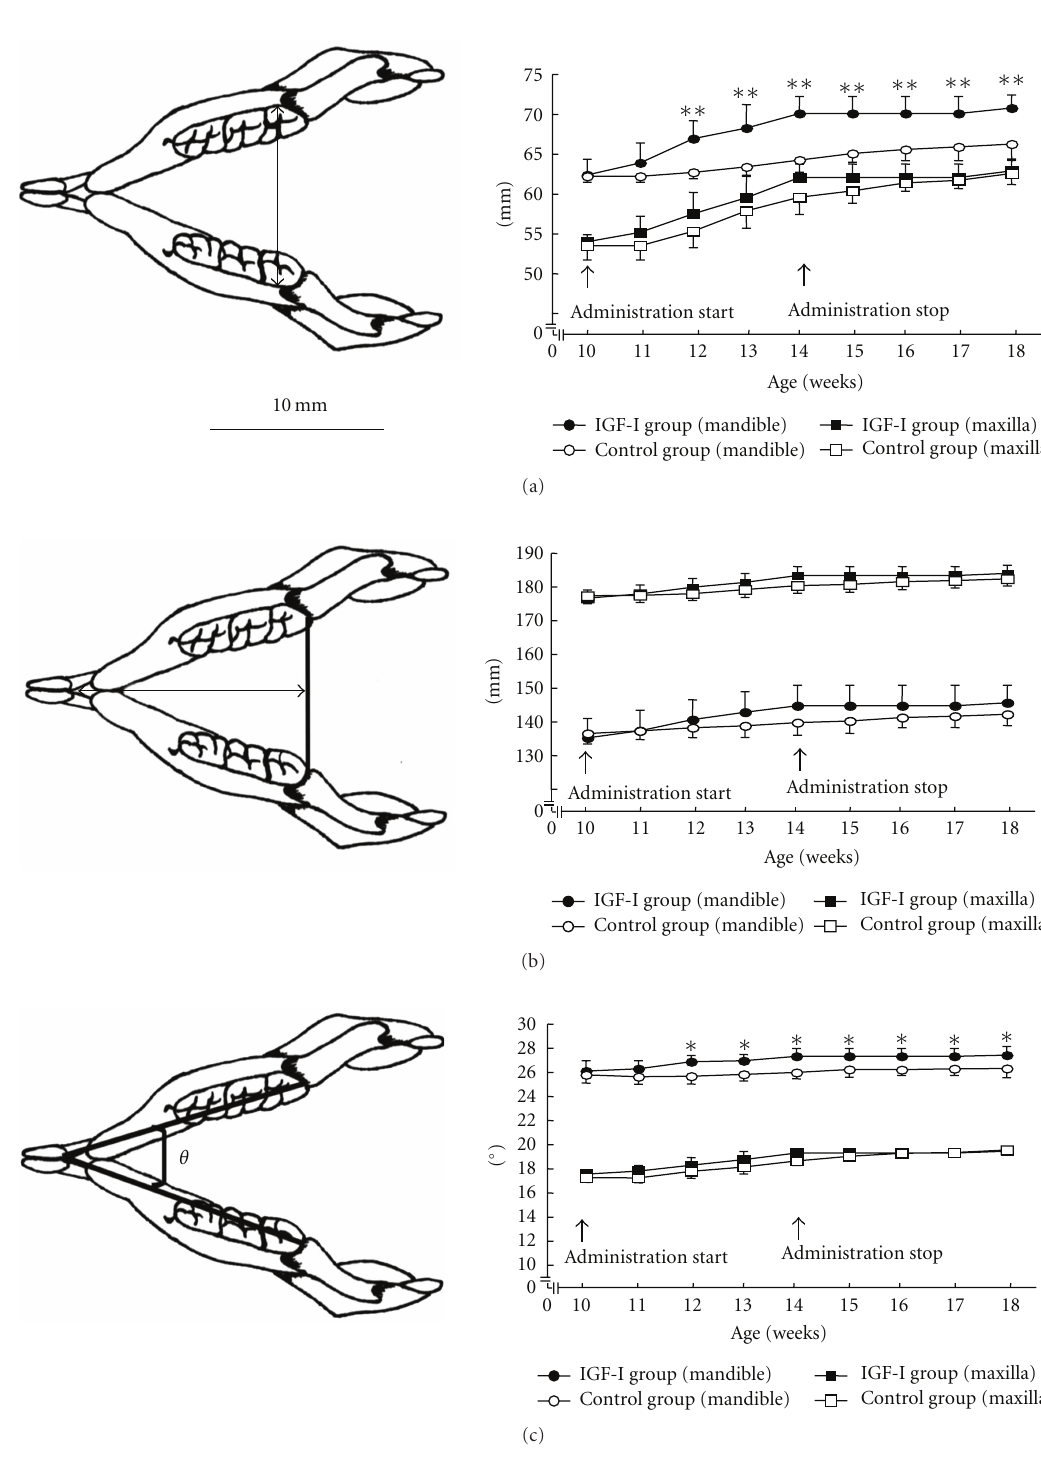
Figure 5: Left: illustration showing measurements for width (a), length (b), and angle θ (c) of the mandibular dental arch. Measurements for the maxillary arch (not shown) were the same as for the mandible. Right: mandibular and maxillary arch measurements during and after administration of IGF-I (mandible: ∗ P < 0 . 05, ∗∗ P < 0 . 01 versus control; maxilla: no significant di ff erences). Closed circles: IGF-I-treated mandibles; open circles: control mandibles; closed squares: IGF-I-treated maxilla; open squares: control maxilla. Data represent the mean ± SD of six rats; adapted from a previous report